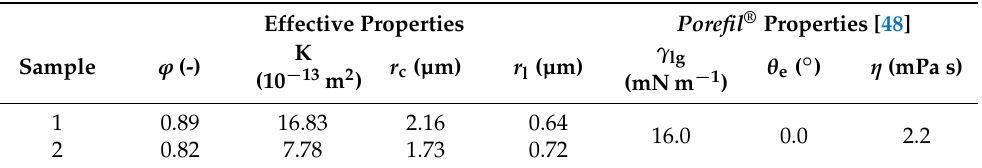
Figure 3. Exemplary extraction of effective properties in a 30 × 30 × 30 µm section of membrane sample 1: ( a ) the resulting velocity distribution of the fluid flow simulation; ( b , c ) visualization of the local ligament and pore radius detection, realized by combining a Euclidean distance map and a thinning algorithm as described in [27]; and ( d , e ) the resulting ligament and pore radius distributions for sample 1 (shown for the complete reconstructed sample). Table 1. Effective properties of the two porous nitrocellulose membranes (porosity ϕ , permeability K, structure parameter r c and r l , and the properties of the wicking liquid Porefil ® (surface tension γ lg , contact angle θ e , dynamic viscosity η )). The geometric properties are extracted from the reconstructed membrane structures (see Figure 2) by applying the methods described in Section